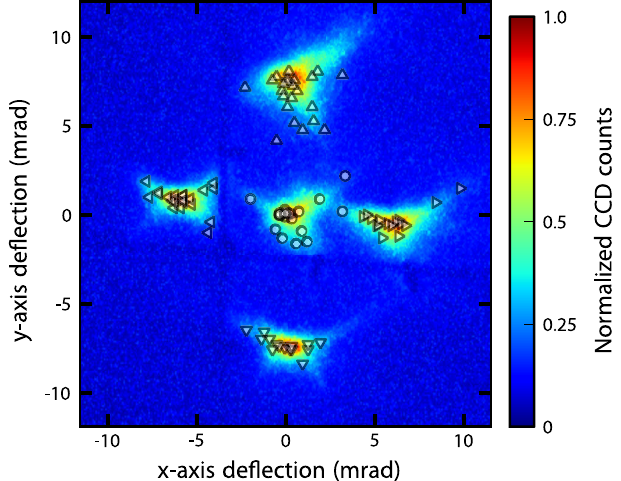
FIG. 5. Electron beam steering: False color summed images observed at S1, 1.12 m behind the electron source with symbols marking the peak position of individual shots. The central spot shows the sum of 18 shots (circles). The surrounding four spots (triangles of differing orientation) were observed after offsetting the second lens transversely to the beam propagation direction in four separate positions. This introduces a dipole moment which deflects the electron beam. The lens was moved by (cid:6) 390 (cid:1) m and (cid:6) 530 (cid:1) m in the x and the y directions and caused corre- sponding angular deflections of 6.1 and 7.3 mrad in the same